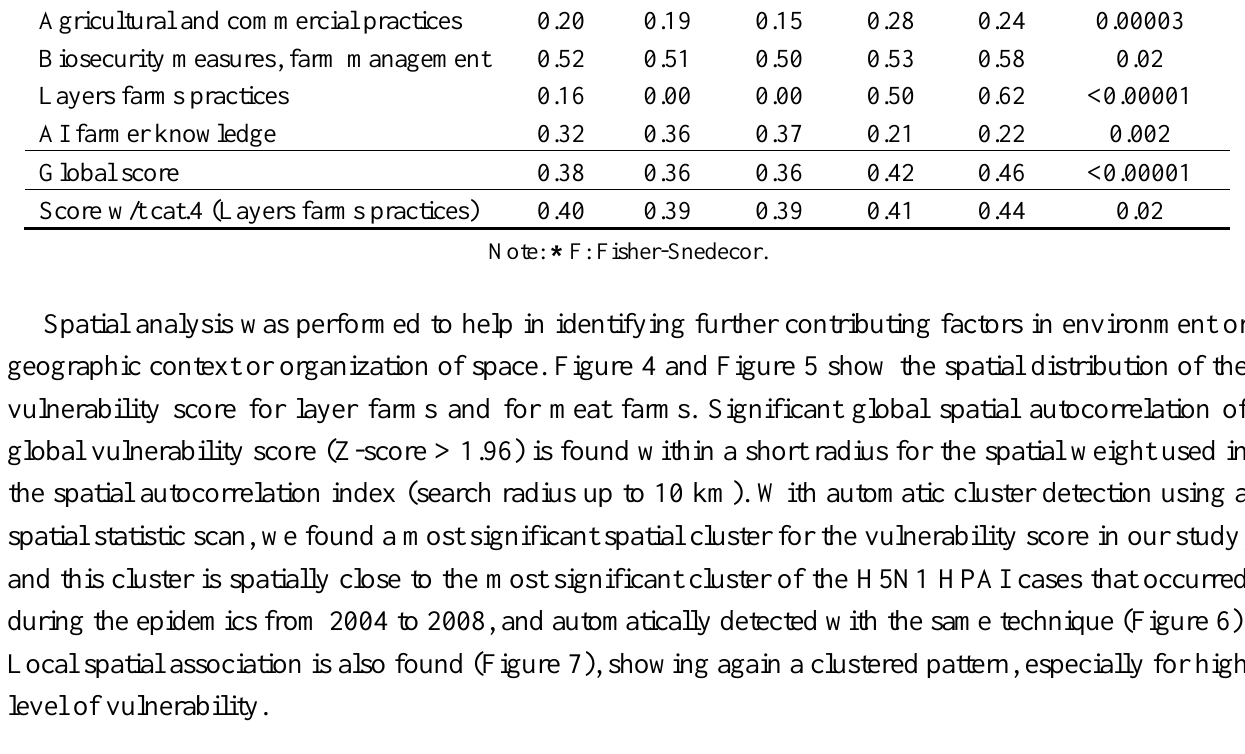
Figure 4. Score of vulnerability, layer farms sector 2 and 3, Nakhon Pathom province, Thailand. Level of vulnerability is given by color graduation and symbol